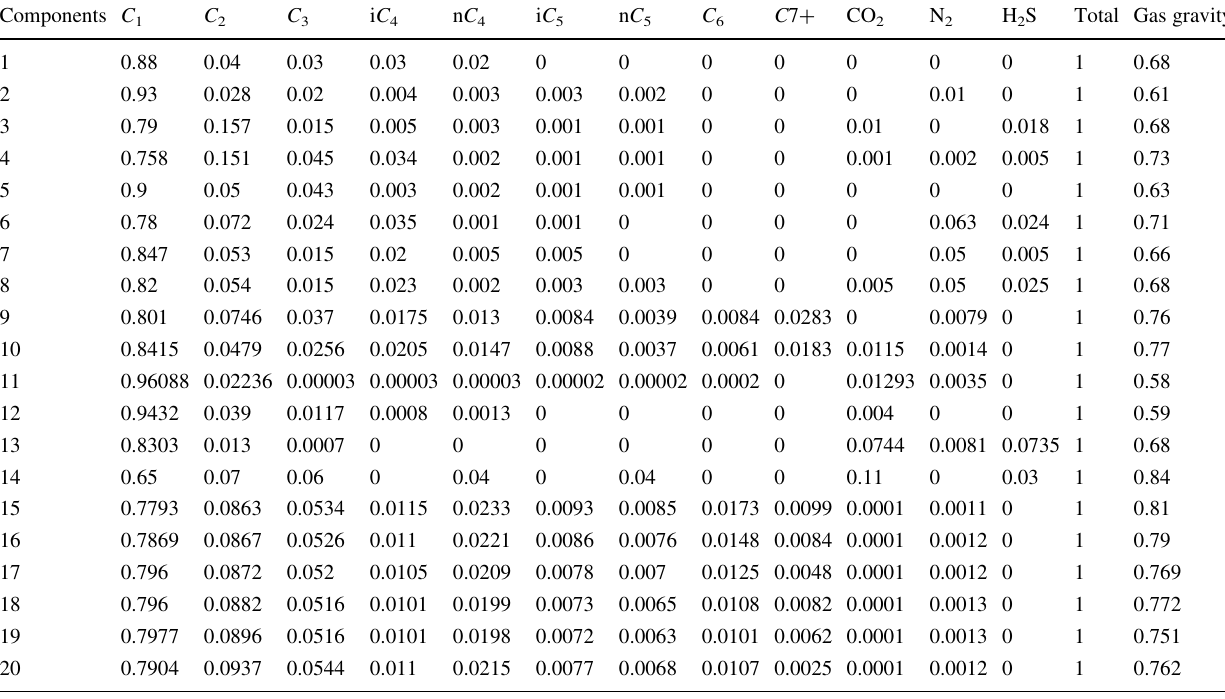
Table 1 Gas component data